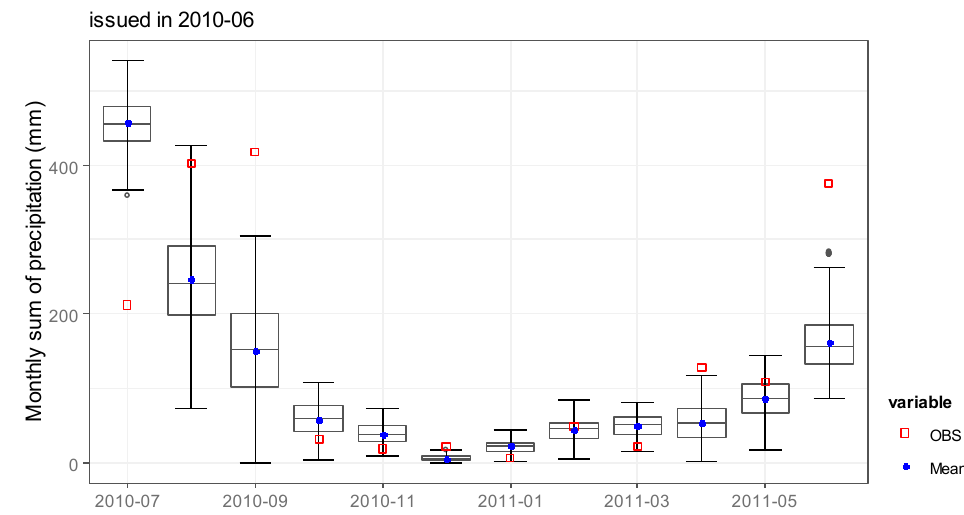
Figure 11. Results of monthly precipitation forecasting from July 2010 to June 2011.